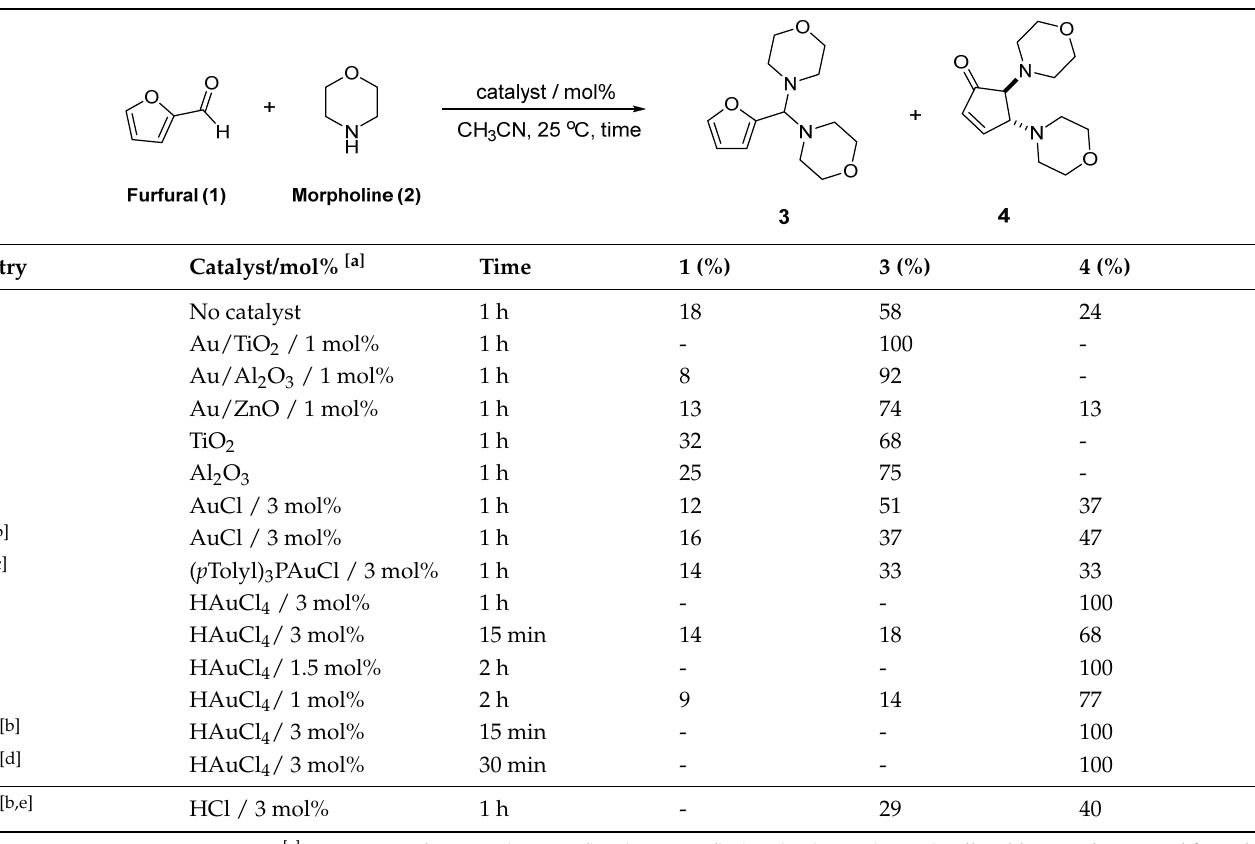
Table 2. Gold catalyst screening for the synthesis of trans -DACPs 4 from 1 and 2 .